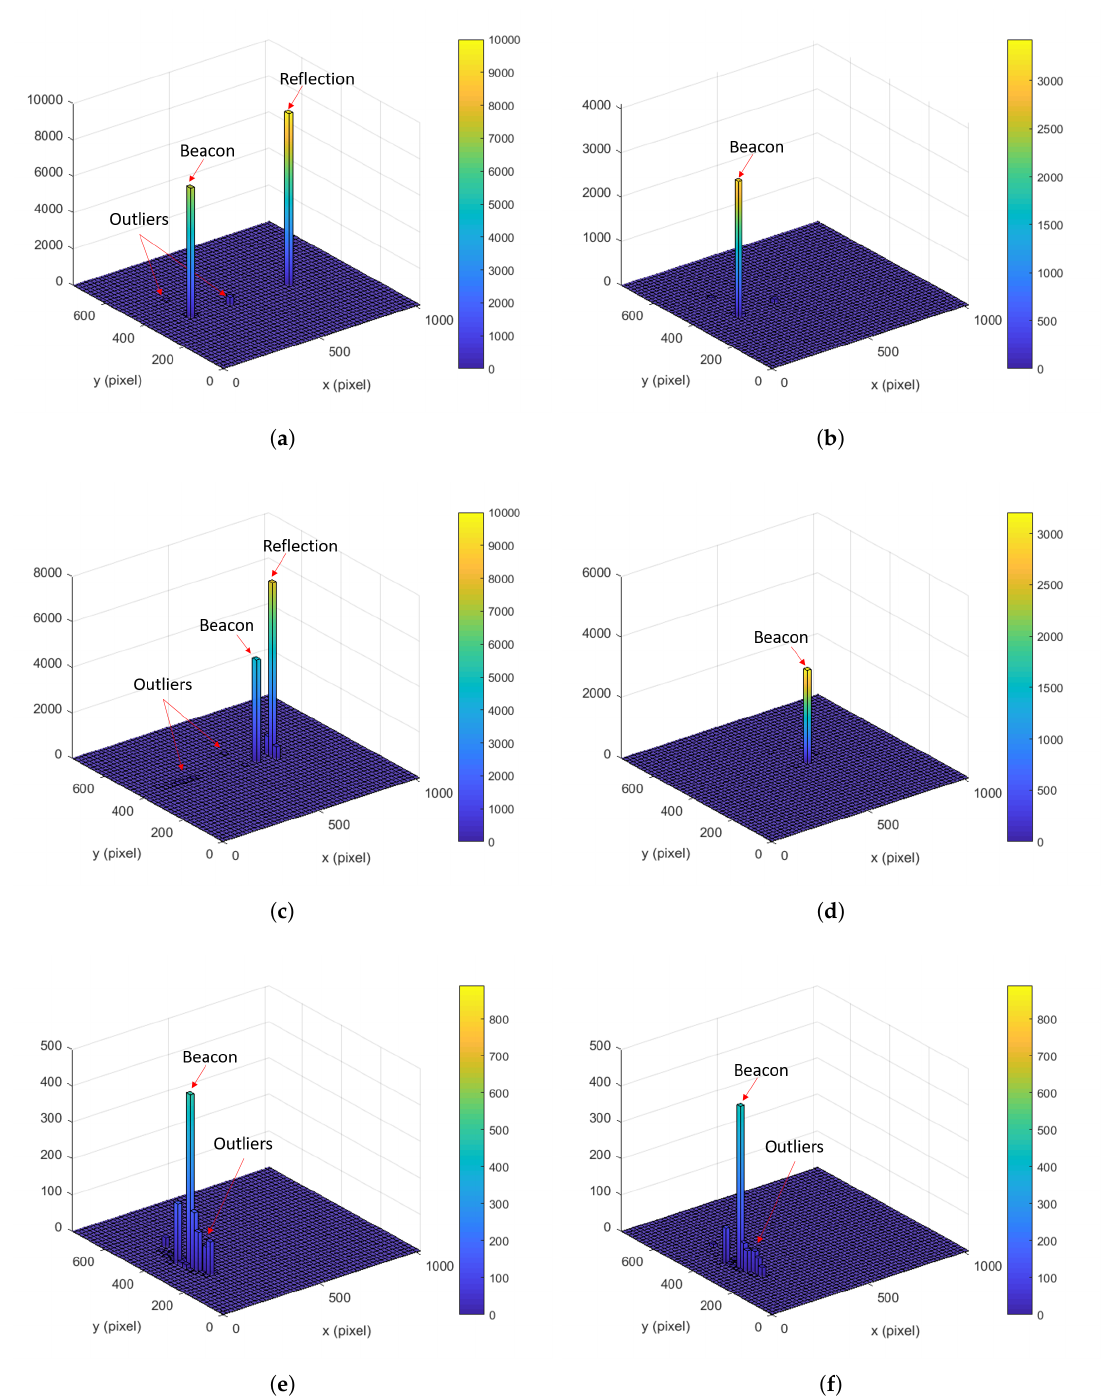
Figure 9. The histogram of the measured data by the IR camera for 100 s; unfiltered: ( a ), ( c ), and ( e ); filtered by the signal modulation: ( b ), ( d ), and ( f ), while varying the distance by 6.1 m (20 ft), 12.2 m (40 ft), and 18.3 m (60 ft). ( a ) 6.1 m (20 ft)/unfiltered; ( b ) 6.1 m (20 ft)/filtered; ( c ) 12.2 m (40 ft)/unfiltered; ( d ) 12.2 m (40 ft)/filtered; ( e ) 18.3 m (60 ft)/unfiltered; ( f ) 18.3 m (60